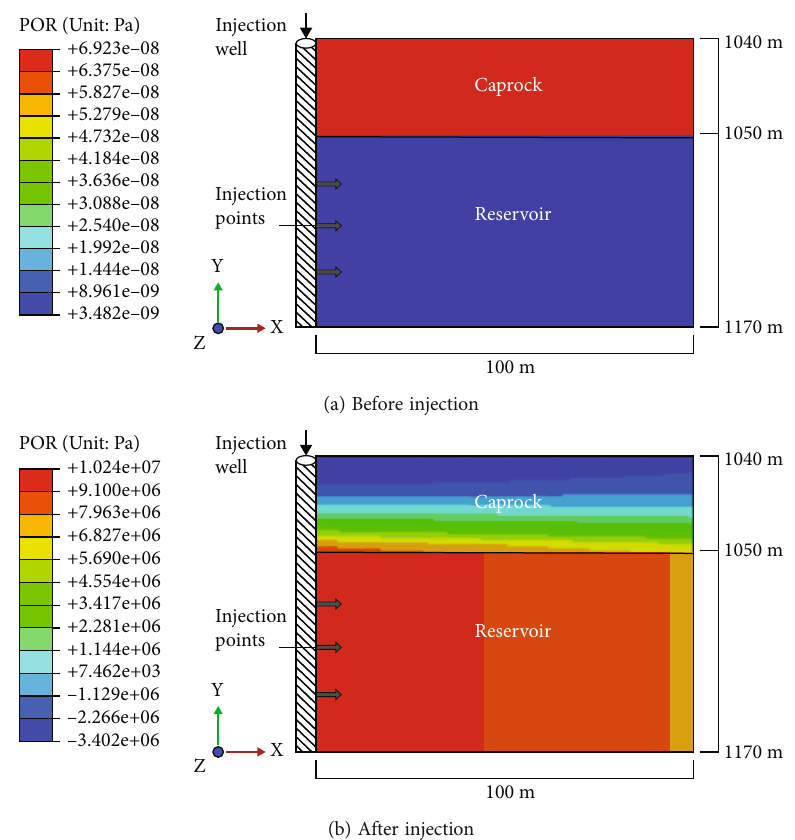
Figure 4: Variation nephogram of excess pore